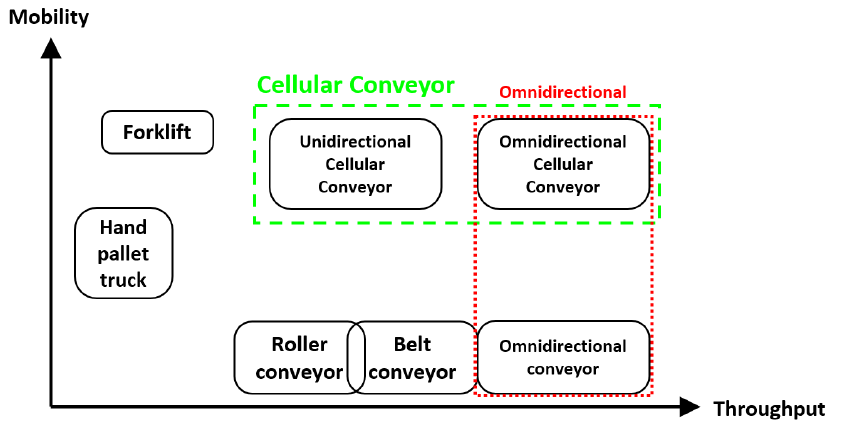
Figure 1. Comparison of different carton carriers.